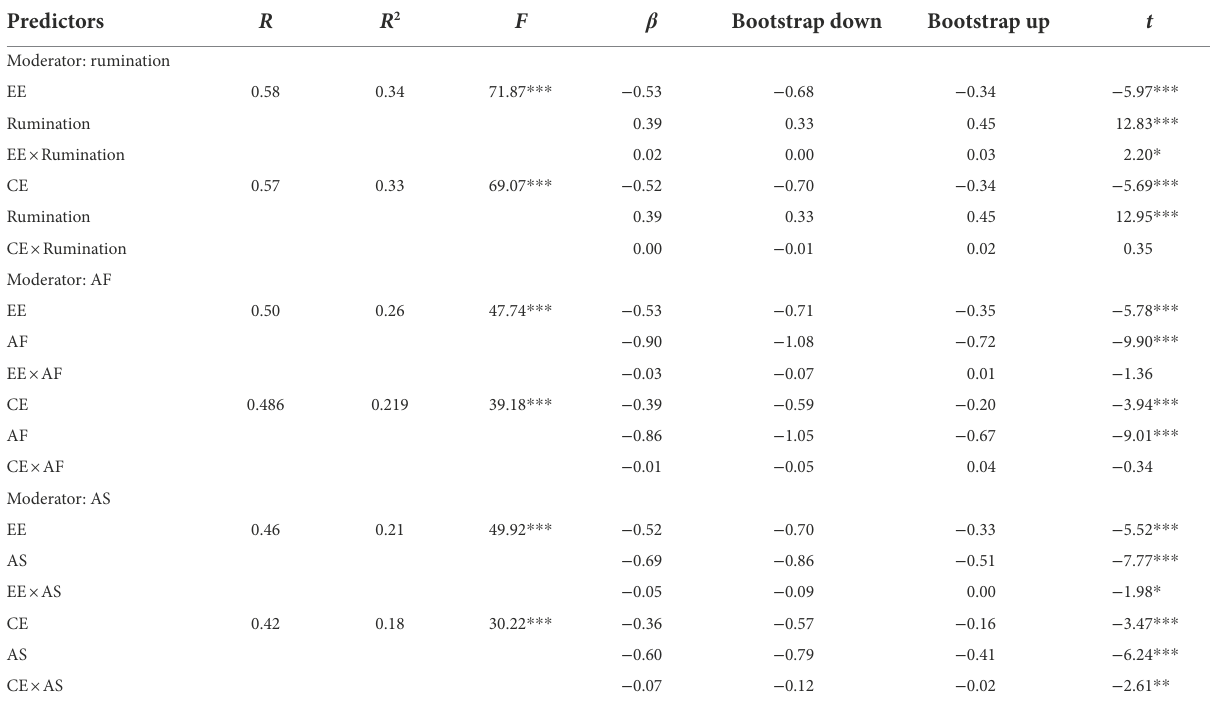
TABLE 2 Results of moderating analysis on the effects of depression.